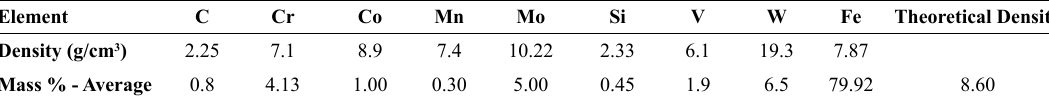
Table 2. Theoretical density of AISI M2 HSS